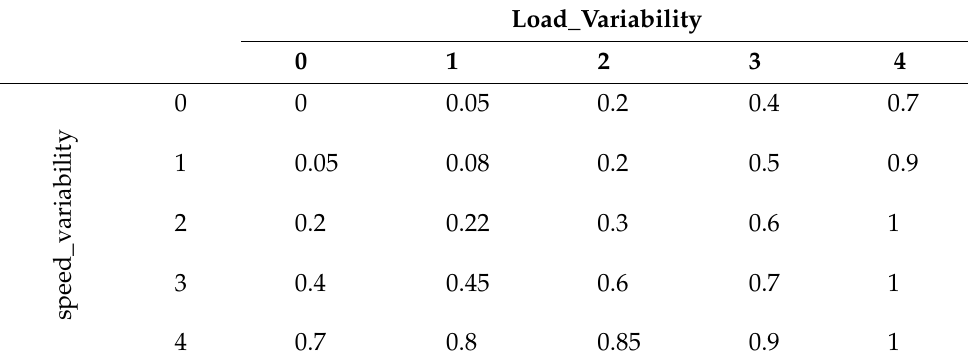
Table A1. Look-up table for Difficulty system